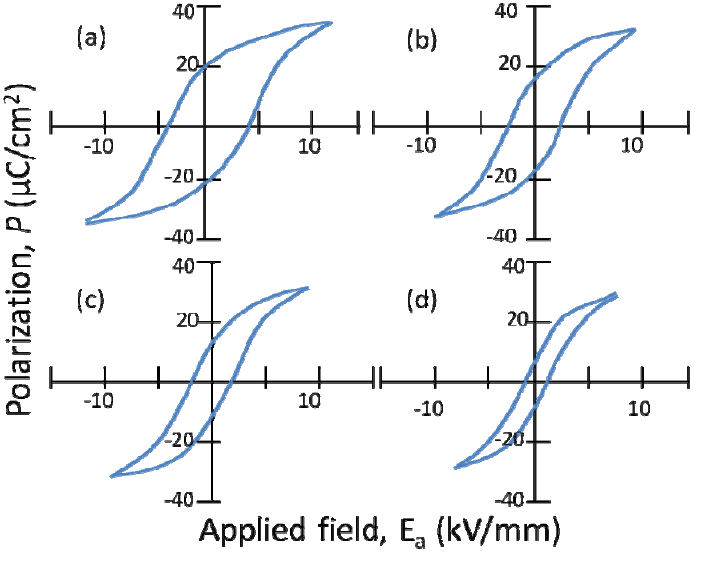
Figure 4. Polarization of KBT measured at temperatures of (a) 100 °C, (b) 200 °C, (c) 240 °C, and (d) 260 °C, reproduced from Hiruma et al.